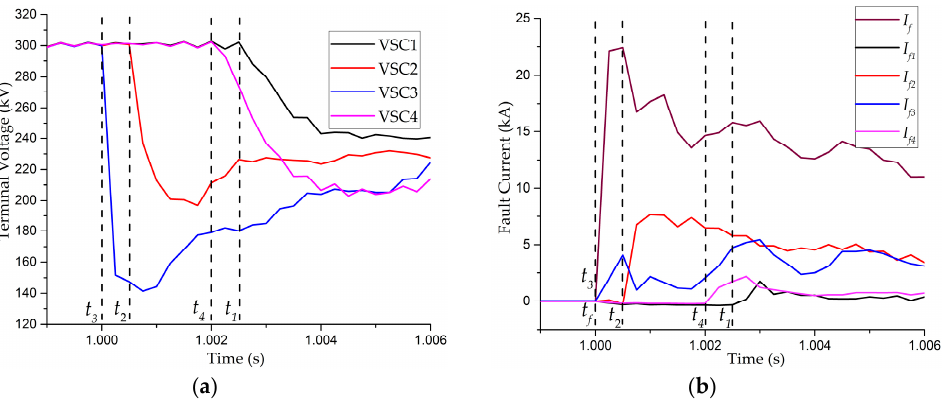
Figure 10. Propagation time delay in MTDC network in case of fault near VSC3. ( a ) Voltage response, ( b ) current response.